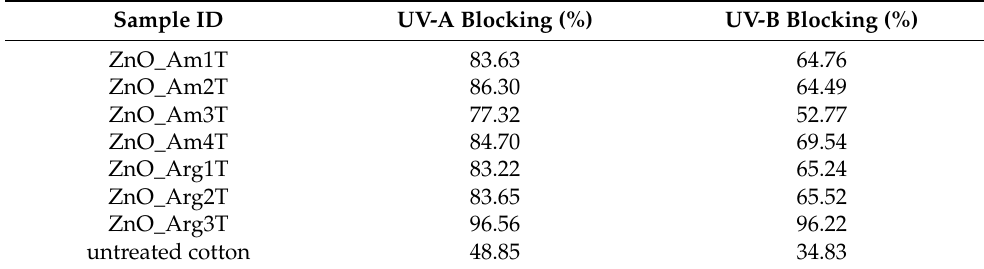
Table 4. The UV blocking efficiency of ZnO-treated